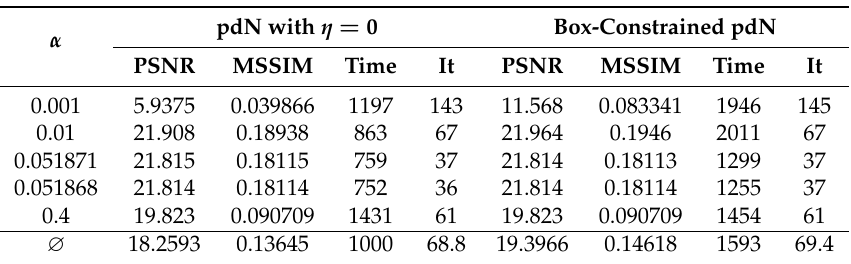
Table 2. Reconstruction of the cameraman-image corrupted by Gaussian blur and Gaussian white noise with σ = 0.1 for different regularization parameters α .